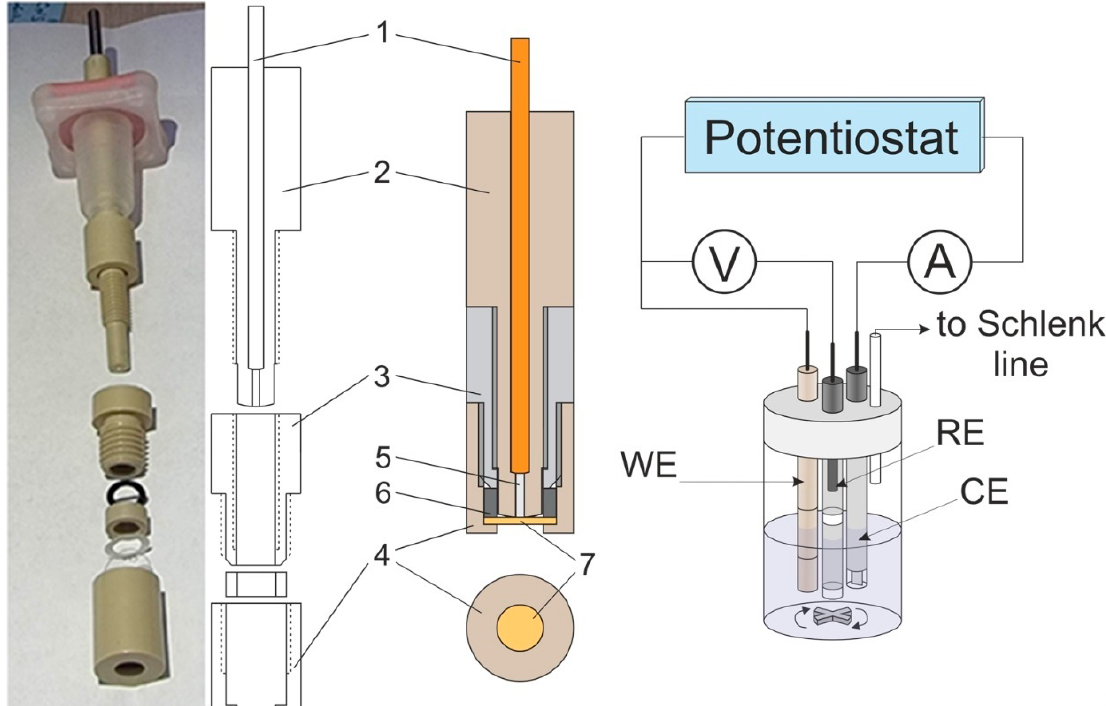
Figure 1. Photo of the working electrode for measuring transport parameters in ion-exchange membranes ( left ) and its scheme in disassembled and assembled states (in the middle), as well as a diagram of the three-electrode cell ( right ) used for measurements. Numbered elements: current supplier (1), body (2), membrane fixator (3), cover (4), platinum rod (5), sealing spacer (6), and membrane (7). Working electrode diameter: 1 mm.